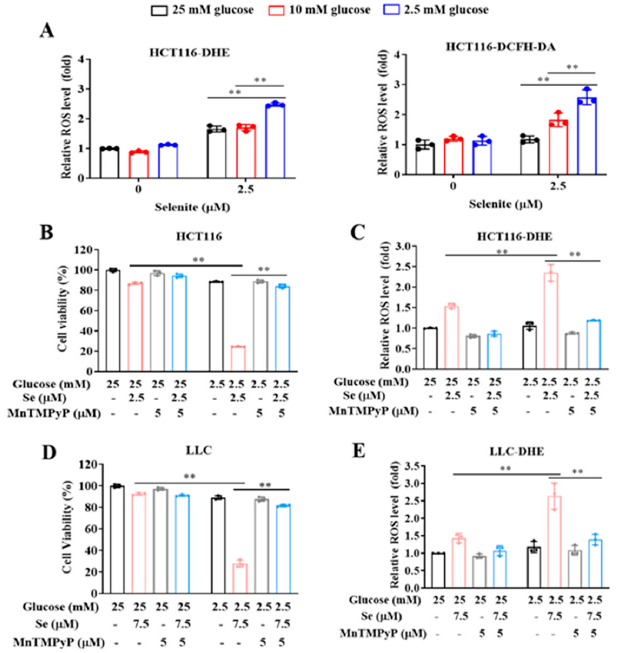
Figure 2. The sensitization effect of glucose limitation on selenite is attributed to elevated ROS generation. ( A ) The intracellular ROS level staining with DHE (for O 2 •− ) or DCFH-DA (for H 2 O 2 ) of HCT116 cells cultured in the medium containing indicated concentrations of glucose with or without treatment of selenite for 22 h. ( B ) Cell viability of HCT116 cells cultured in the medium containing 25 mM or 2.5 mM glucose with or without treatment of selenite or MnTMPyP for 24 h. ( C ) O 2 •− levels of HCT116 cells cultured in the medium containing 25 mM or 2.5 mM glucose with or without treatment of selenite or MnTMPyP for 22 h. ( D ) Cell viability of LLC cells cultured in the medium containing 25 mM or 2.5 mM glucose with or without treatment of selenite or MnTMPyP for 24 h. ( E ) O 2 •− levels of LLC cells cultured in the medium containing 25 mM or 2.5 mM glucose with or without treatment of selenite or MnTMPyP for 22 h. Results are representative of three biologically independent experiments. Data are expressed as mean ± SD, ** p < 0.01. MnTMPyP: manganese